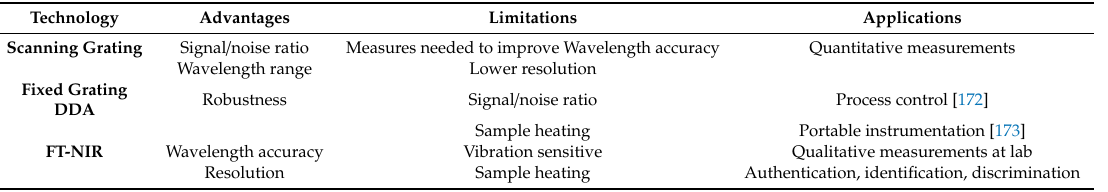
Table 2. Major distinctions between spectrometer technologies and their preferred